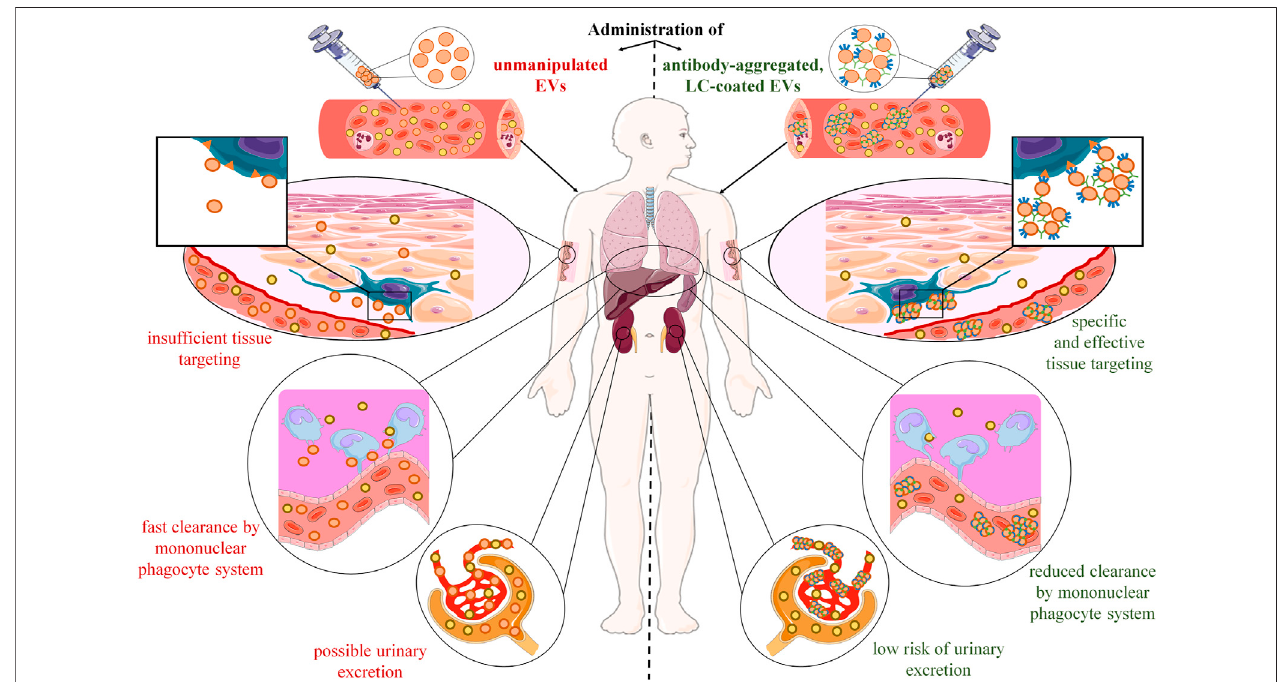
FIGURE1| Postulatedadvantagesofextracellularvesicle(EV)aggregationwithantigen-speci fi cantibodiesandcoatingwithantigen-speci fi clightchains(LC).After systemic administration, therapeutic EVs disperse and mix with their counterparts in the circulation, from which they pass into the tissues. However, their tissue distribution is at least partly random with the preferential accumulation in mononuclear phagocyte-enriched organs, such as liver, spleen, and lungs, where they are rapidly cleared by macrophages. In addition, injected EVs could likely be excreted in urine due to their putative ability to penetrate kidney ’ s glomerular fi ltration barrier. Altogether, these hurdles make desired tissue penetration and cell targeting insuf fi cient to induce the expected therapeutic effect. However, recent research fi ndingsshowedthattheselimitationscouldbeovercomewiththeuseofantigen-speci fi cantibodiesandlightchains.IncubatingEVswithantigen-speci fi cIgGantibodies leadstotheir aggregation, which enhances their biological ef fi cacy byincreasing theamount ofEVs thattargetdesired cell population, and by loweringthe riskofurinary excretion.Inaddition,coatingEVswithantigen-speci fi cLCsdirectsthemtowardstargetcells,whichaugmentstheselectivityoftissuetargeting,andlimitstheunwanted clearance by